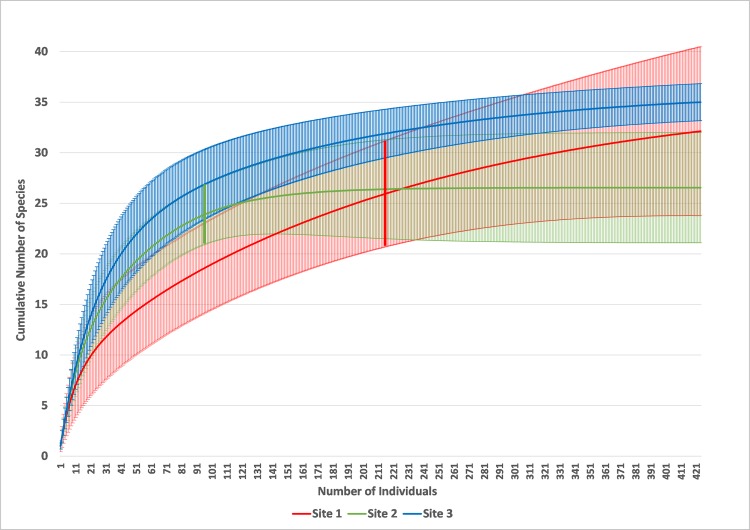
Rarefied species accumulation curves based on 1000 randomizations and with 95% confidence intervals; solid lines are the species accumulation curves and vertical lines are the 95% confidence interval.Red line: Site 1 –polluted secondary forest; green line: Site 2 –unpolluted secondary forest; blue line: Site 3 –pristine forest. The thick vertical green and red lines indicate the points from which the respective data have been extrapolated.